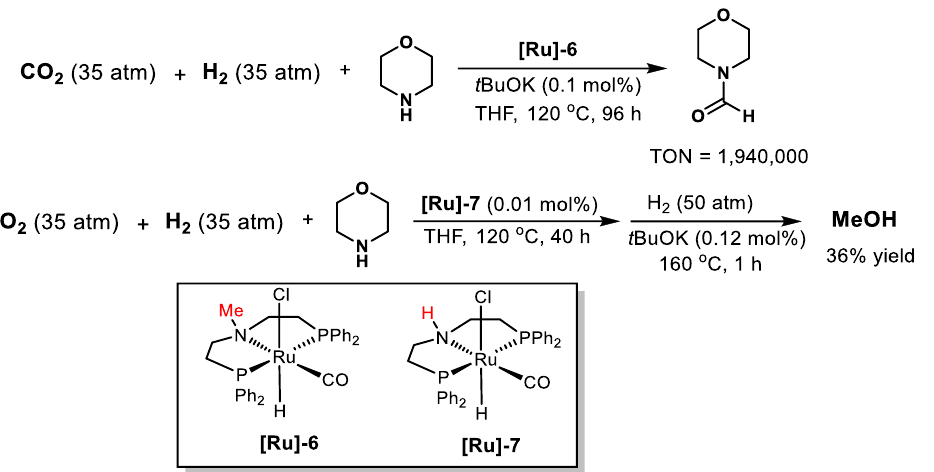
Figure 6. Ru-catalyzed hydrogenation of CO 2 with morpholine as the amine source.